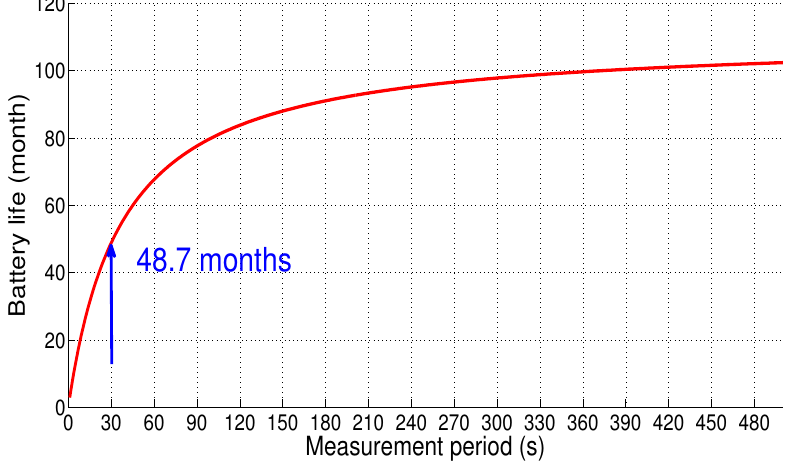
Figure 20. Sensor node autonomy: Scenario 3.